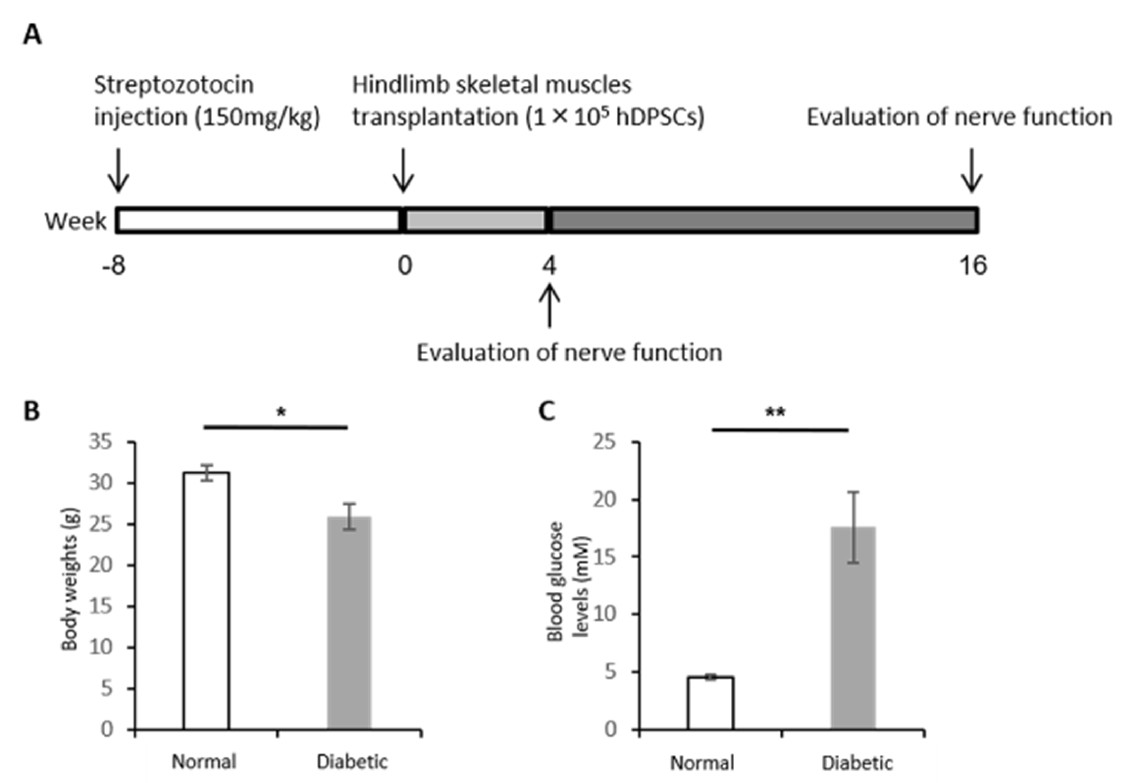
Figure 3. Experimental animal protocol. ( A ) hDPSCs were transplanted into unilateral hindlimb skeletal muscles 8 weeks after streptozotocin injection, and physiological assessments were performed 4 and 16 weeks after hDPSC transplantation. ( B ) Body weights. ( C ) Blood glucose concentrations. The results are expressed as the mean ± SEM ( n = 6). * p < 0.05, ** p < 0.01.